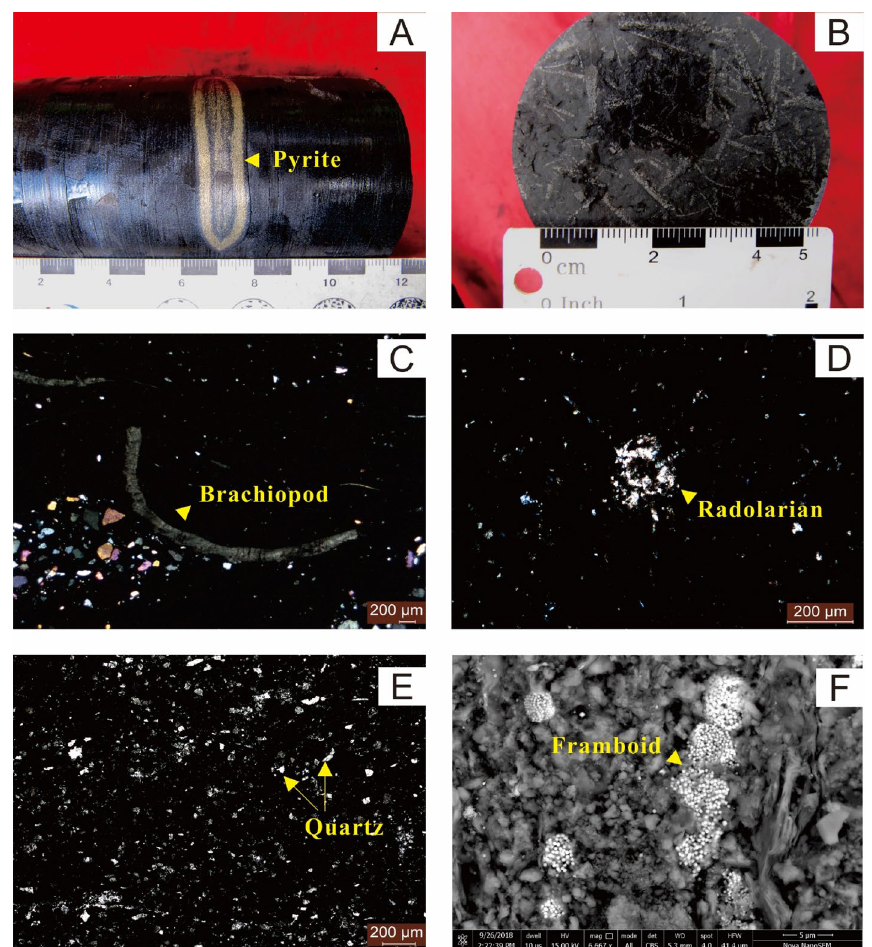
Figure 2. Sedimentary features of the Wufeng-Longmaxi formations in Xindi No. 2 well, Sichuan Basin, South China. ( A ) Pyrite occurs as girdles in the black shales of the Longmaxi Formation ( B ) Graptolites developed